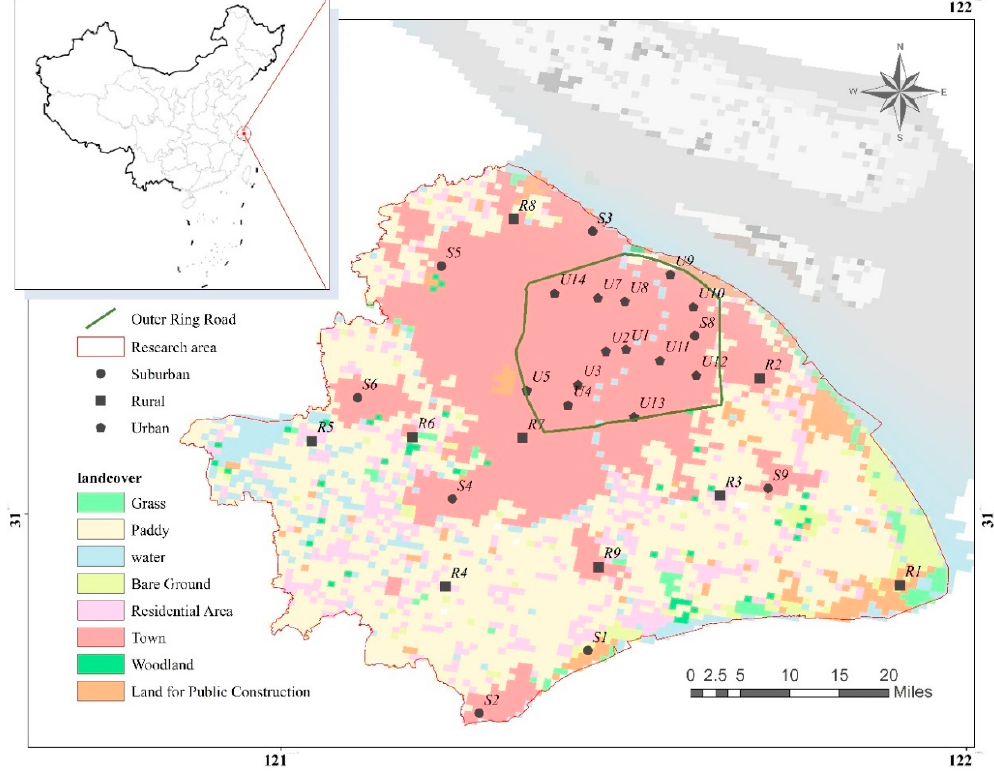
Figure 1. Schematic diagram of the sampling sites and their land use type.